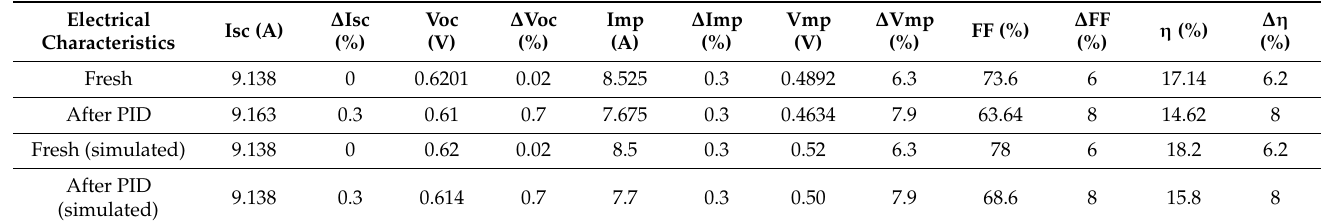
Figure 6. Validation of the Simulation model: ( a ) One sun-illuminated I-V curve fresh and after PID stress test, ( b ) I-V curves of simulated and measured fresh cells, and ( c ) IV curve of simulated PID effect. Table 1. Electrical Characteristics of Experimented and Simulated Before and After PID Stress.